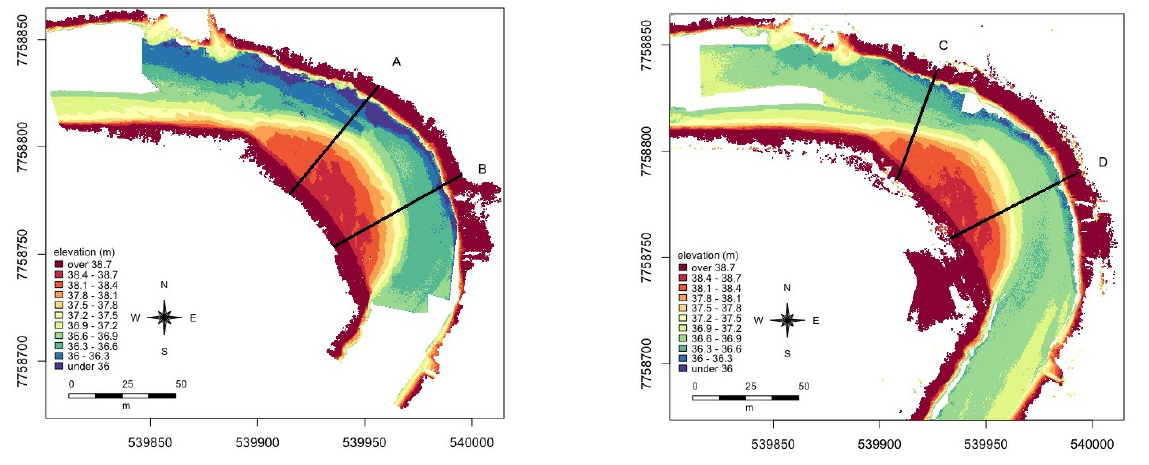
Figure 9. Seamless digital elevation model of 2010 and 2011 combining mobile laser scanning data with the UAV-based bathymetry as a 3D point cloud coloured by elevation. The lines indicate the transects shown in Figure 10.